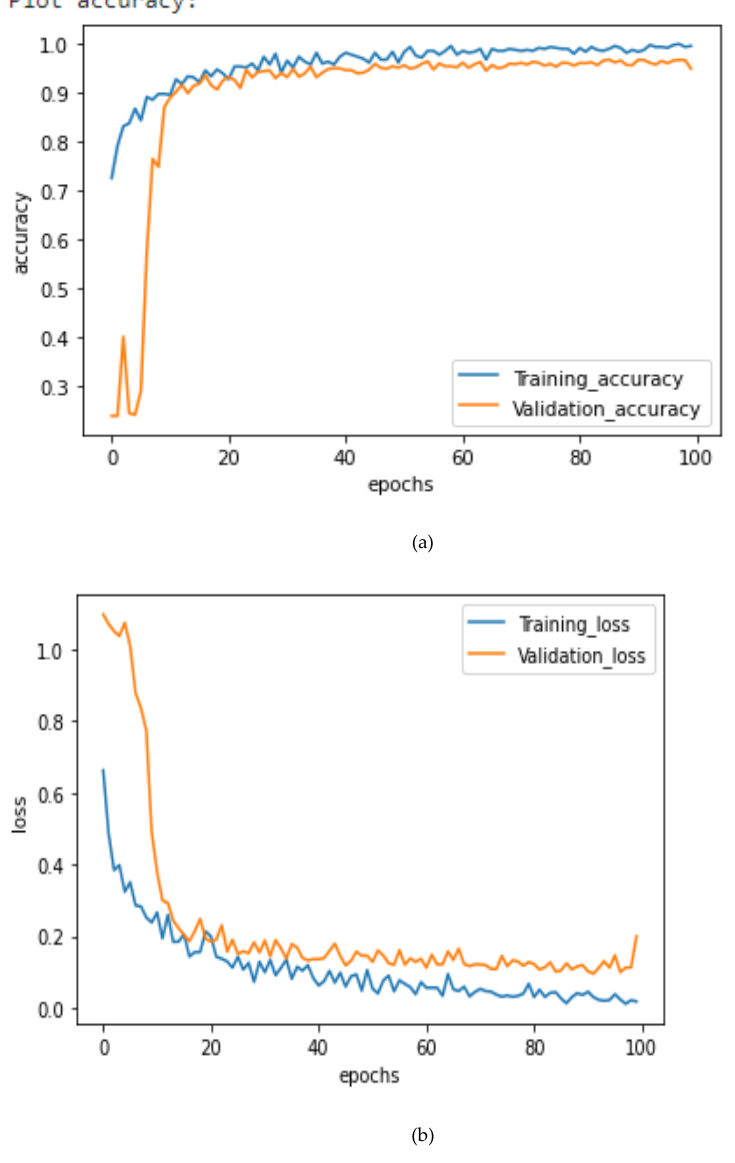
Figure 8. COVID-AleXception Loss and Accuracy curves. ( a ) Training and Validation Accuracy, ( b ) Training and Validation Loss. ( b ) Training and Validation Loss. Table 5. Model classification results for a 3-category classification task for the original